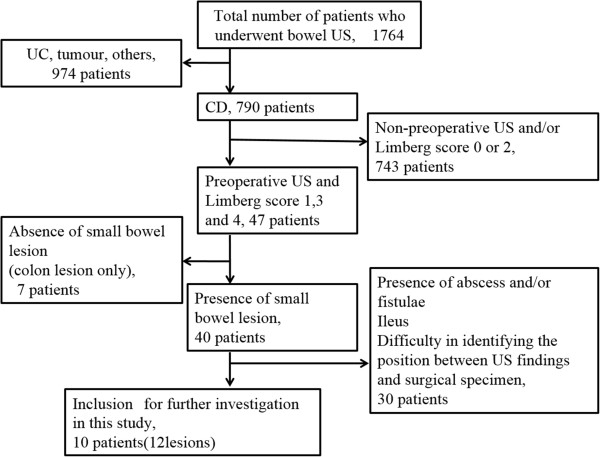
Inclusion and exclusion criteria for this study. A total of 1,764 patients underwent color Doppler US examinations from January 2008 to March 2012; of these, 790 patients had CD. In total, 743 patients who did not undergo US before the operation and/or whose Limberg score of Doppler US was 0 or 2 were excluded. Forty-seven patients underwent surgery and had Grade 1, 3, or 4 Limberg score. Seven patients without small bowel lesions (colon lesions only) were excluded, and 30 patients with abscesses, fistulae, ileus, and/or difficulty in identifying the position between US findings and surgical specimens were also excluded.